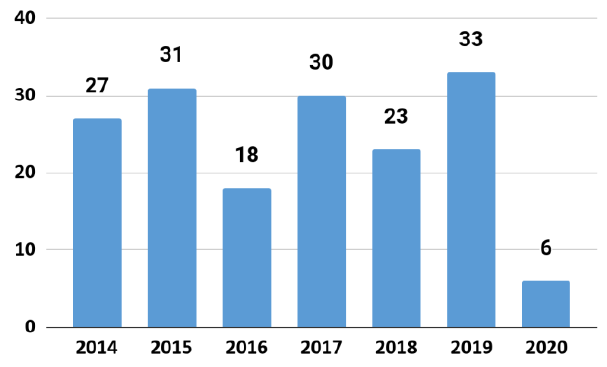
Figure 3. Papers distribution by year.